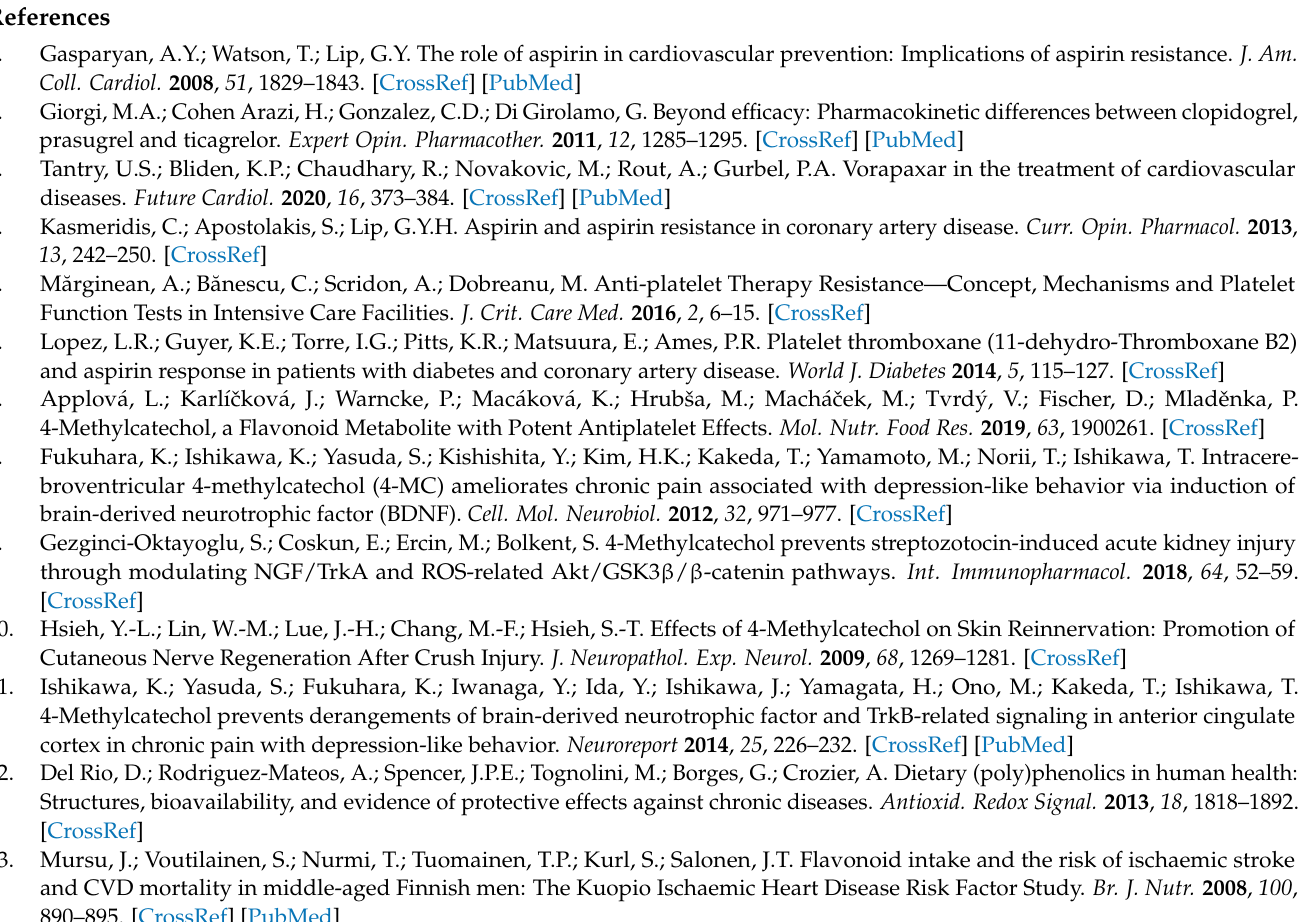
4-methylcatechol. Table S1: Summary of diagnoses of the blood donors. Table S2: Summary of medications taken by the blood donors at the time of blood draw. Table S3: Level of statistical significance of relationships between biochemical and anthropometric parameters with aggregatory responses to